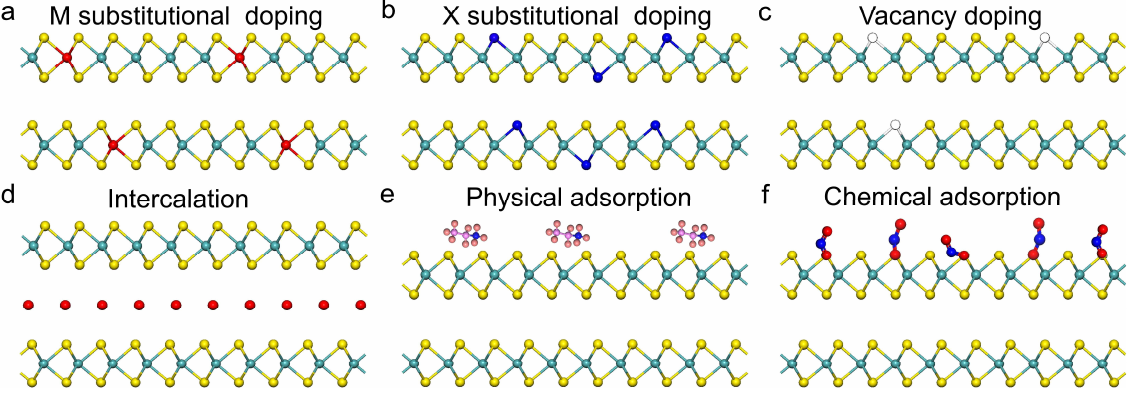
Figure 2. Schematic diagram of different doping types. The yellow and blue balls in the schematic stand for the intrinsic atoms in 2DMs. ( a , b ) M and X substitutional doping formed in 2DMs. The red and navy-blue balls in the schematic stand for the M substitutional atoms and X substitutional atoms, respectively. ( c ) Vacancy doping formed in 2DMs. ( d ) Atom or molecular intercalation formed in the van der Waals gaps of 2DMs. The red balls stand for the intercalated atoms or molecules. ( e , f ) Physical and chemical adsorption formed on the surface of 2DMs.